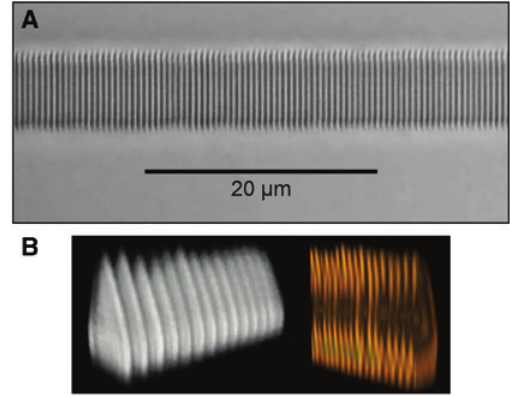
Figure 5: (A) Top-view transmission differential interference con- trast (DIC) microscope image of a first-order WBG structure (period Λ ≈ 500 nm) fabricated in a Kigre QX phosphate sample using the modulated burst method. (B) Third-harmonic generation (THG) image of a fourth-order WBG structure in the same sample using an adaptive-optical (AO) microscope [32]. The typical triangular cross- section of an index structure created using the slit method [33] is